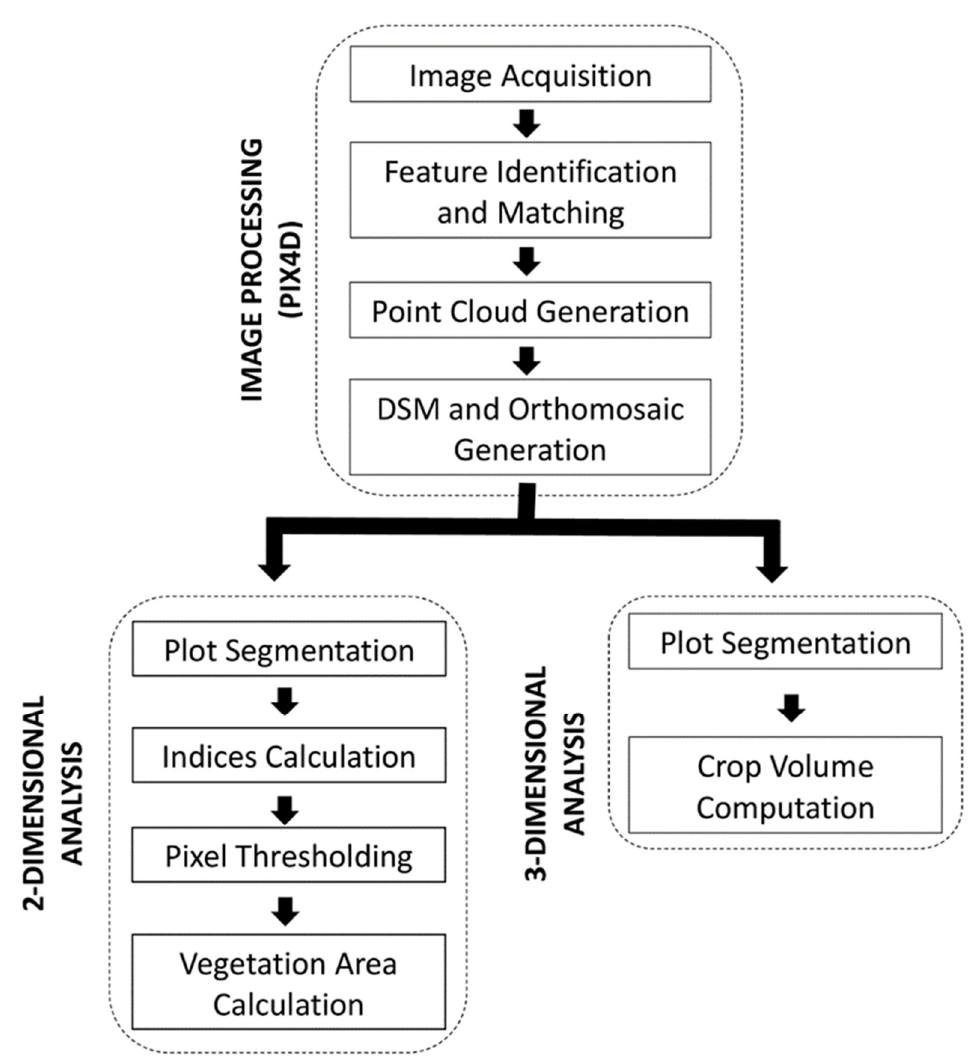
Figure 8. Image processing and analysis workflow.